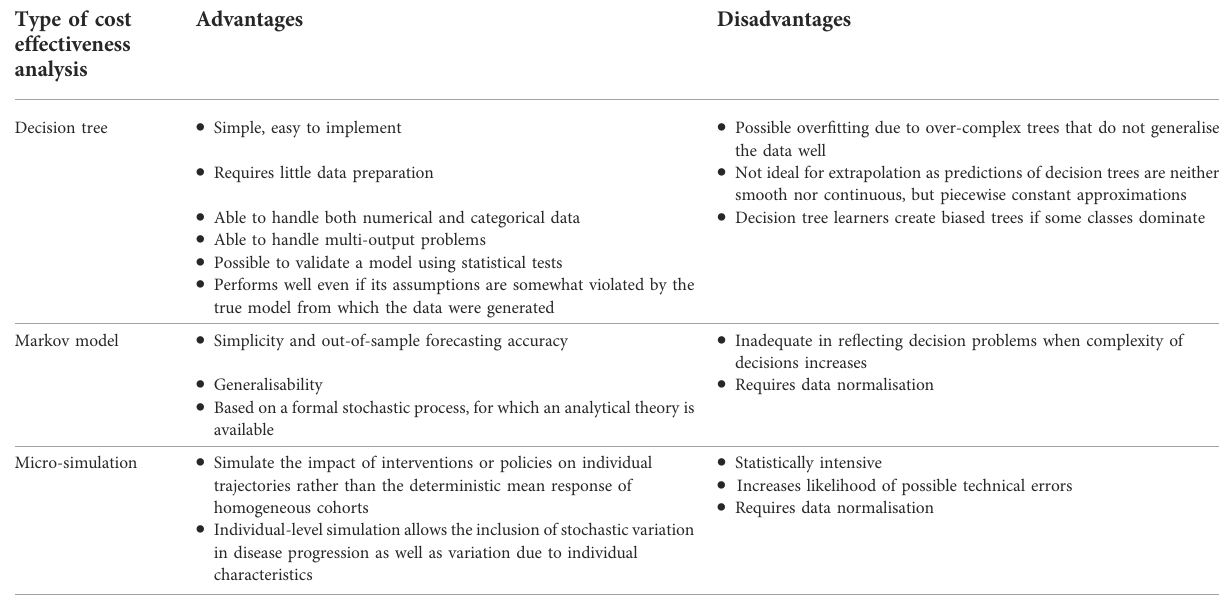
TABLE 1 Types of cost effectiveness analyses and their advantages and